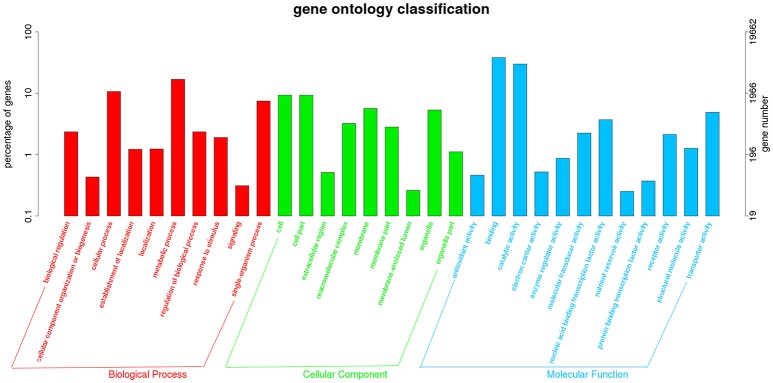
Histogram representation of Gene Ontology classification.